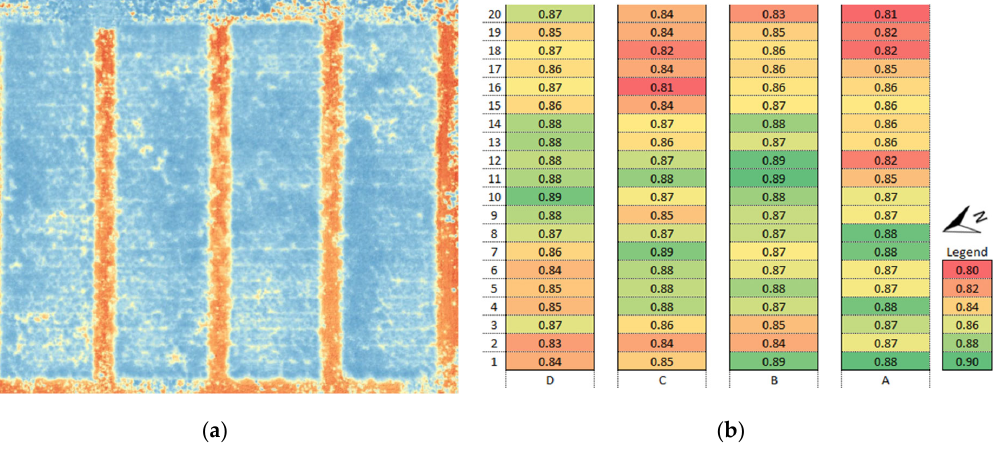
Figure 6. Orthomosaic of BNDVI values from the multispectral UAV survey from 1 May 2020 ( a ) and average BNDVI values calculated for individual plots of the field trial ( b ).